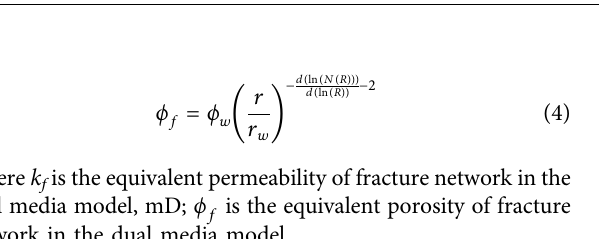
Frontiers in Earth Science |